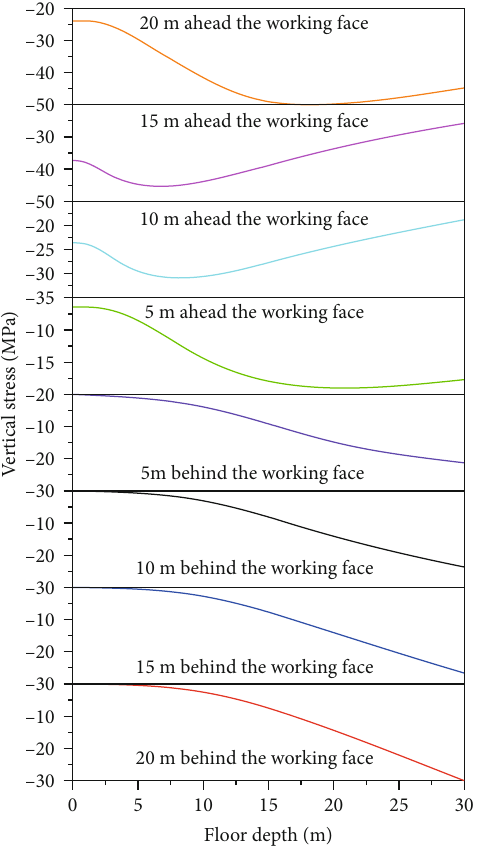
Figure 6: Stress distribution of fl